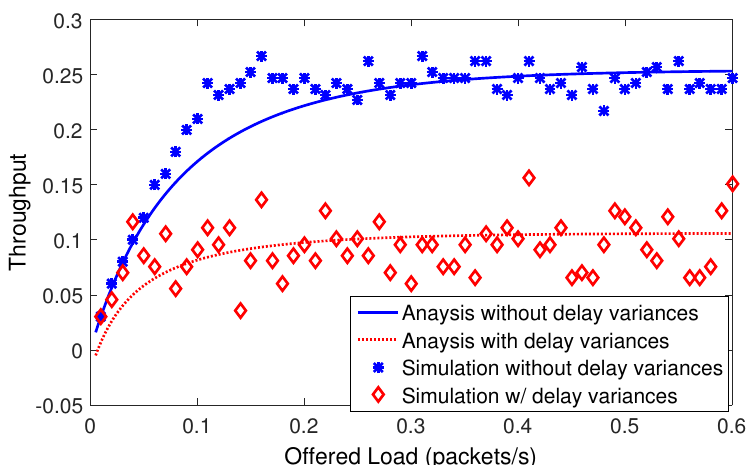
Figure 5. Impact of small-scale delay variation on throughput. The small-scale delay variation decreases the throughput of Slotted-FAMA.